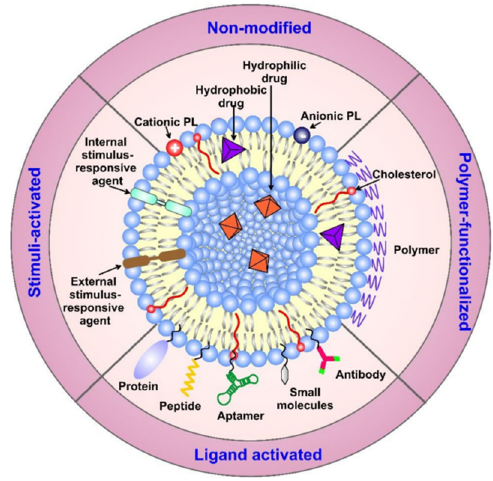
Figure 2. Surface modification strategies of liposomes, together with their classification. The modified carriers can contain active components, such as drugs, small molecules, proteins, and/or targeting moieties, such as antibodies, peptides, aptamers, etc., conjugated on the surface of the vehicles through different linkers, non-covalent or covalent bonds, and electrostatic interactions. Abbreviation: PL-phospholipid. Reprinted with permission from Ref. [87]. 2022, Molecular Diversity Preservation International. Table 2. Properties of DOPC/DOPE, DOPC, and DOPC/Cholesterol liposomes. Reproduced with permission from [91].